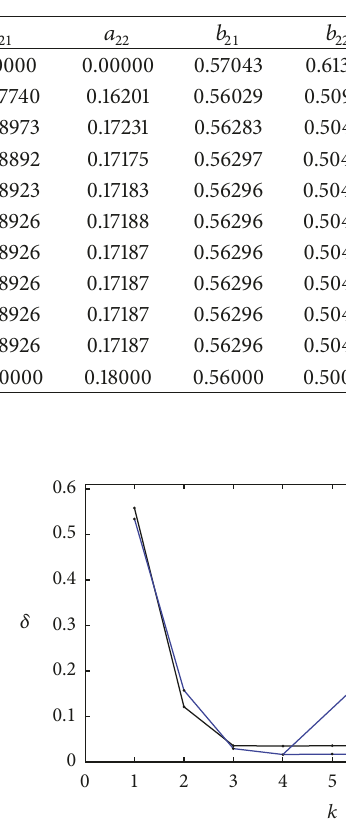
Table 2: The H-LSI parameter estimates and errors for Example 1.